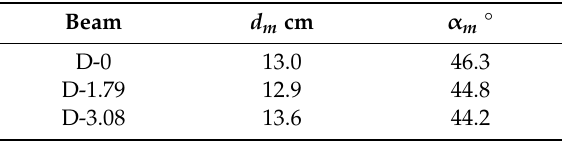
Table 4. Cracking